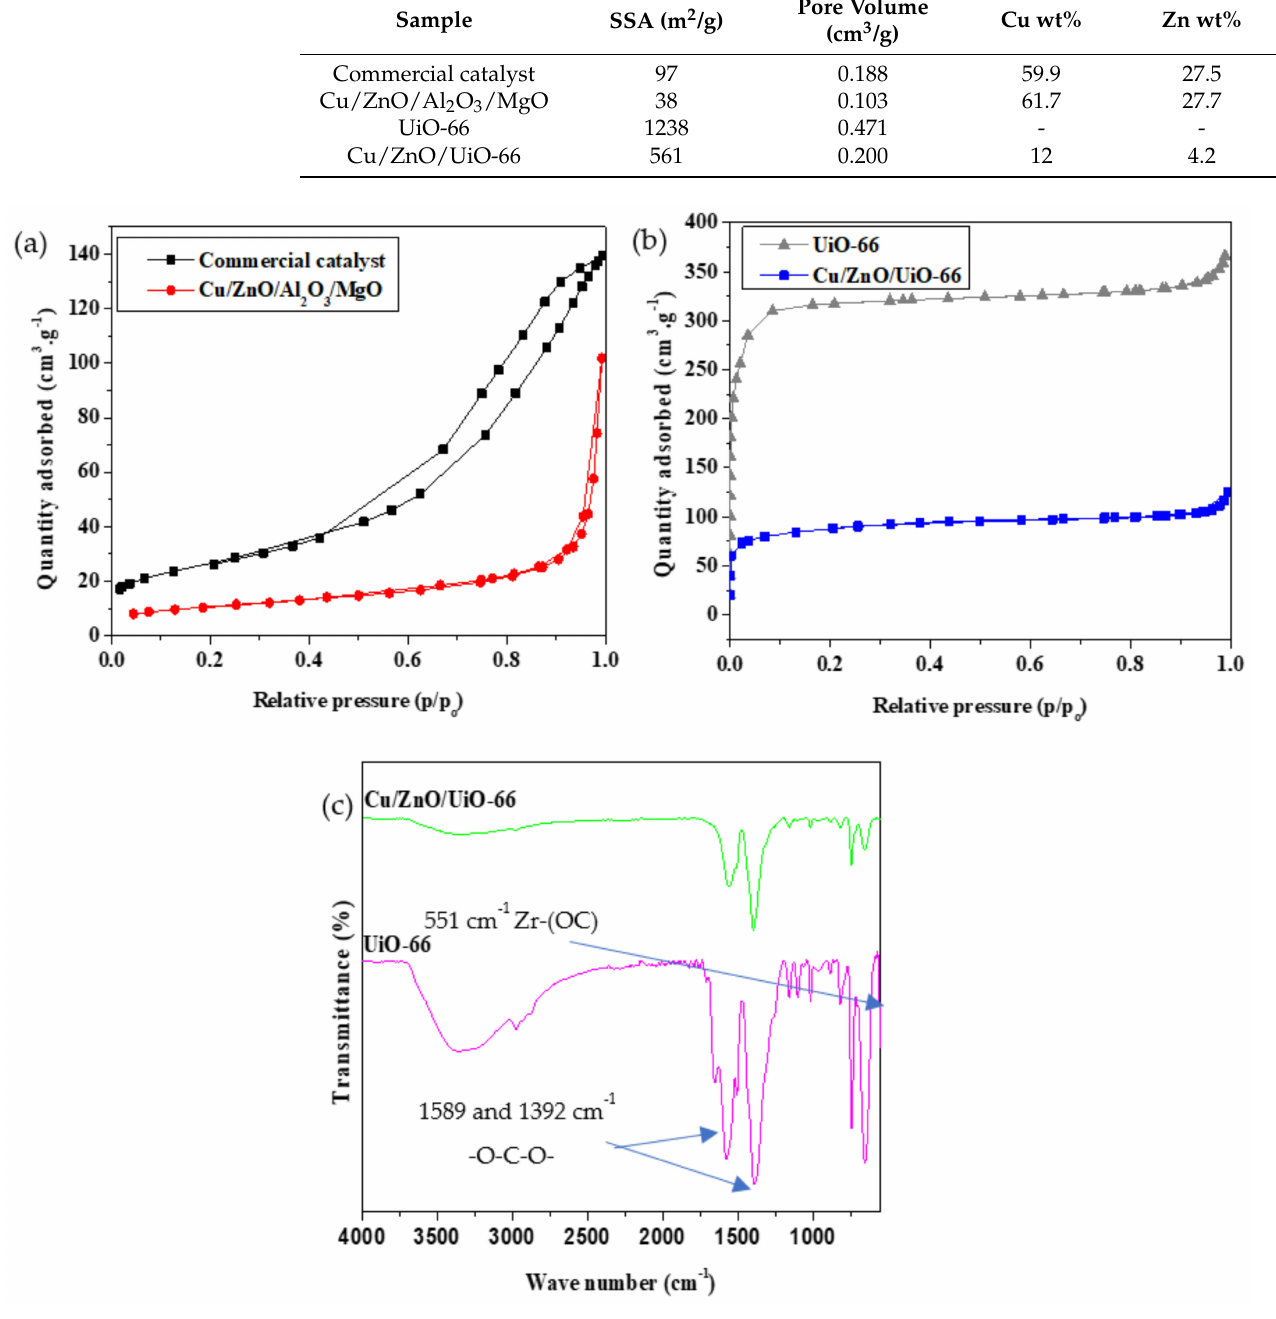
Figure 2. Nitrogen sorption isotherms at 77 K of ( a ) commercial catalyst and Cu/ZnO/Al 2 O 3 /MgO catalyst; ( b ) UiO-66 and Cu/ZnO/UiO-66; and ( c ) FTIR spectra of UiO-66 and